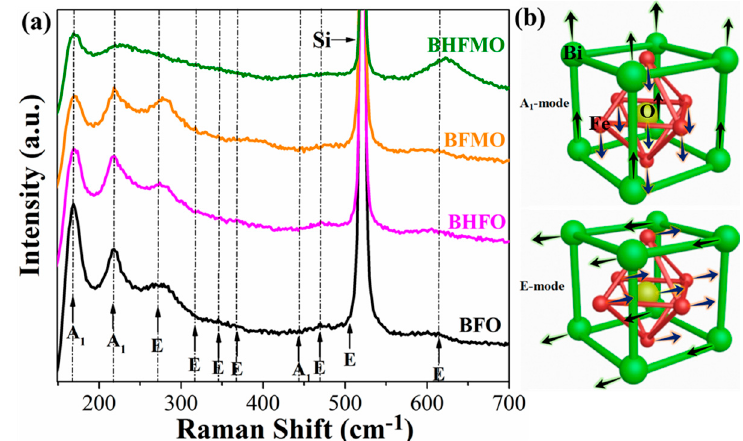
Figure 4. ( a ) Raman scattering diagrams of BFO, BHFO, BFMO and BHFMO thin films at the room temperature; ( b ) Illustrations show the A 1 and E vibration normal modes for temperature; ( b ) Illustrations show the A 1 and E vibration normal modes for BFO.